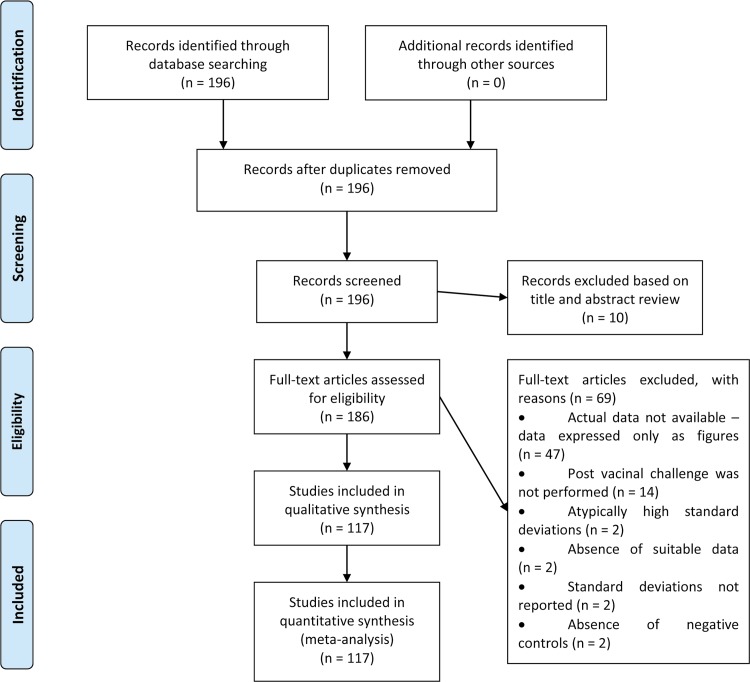
Flow chart describing the selection of articles for inclusion in the meta-analysis.